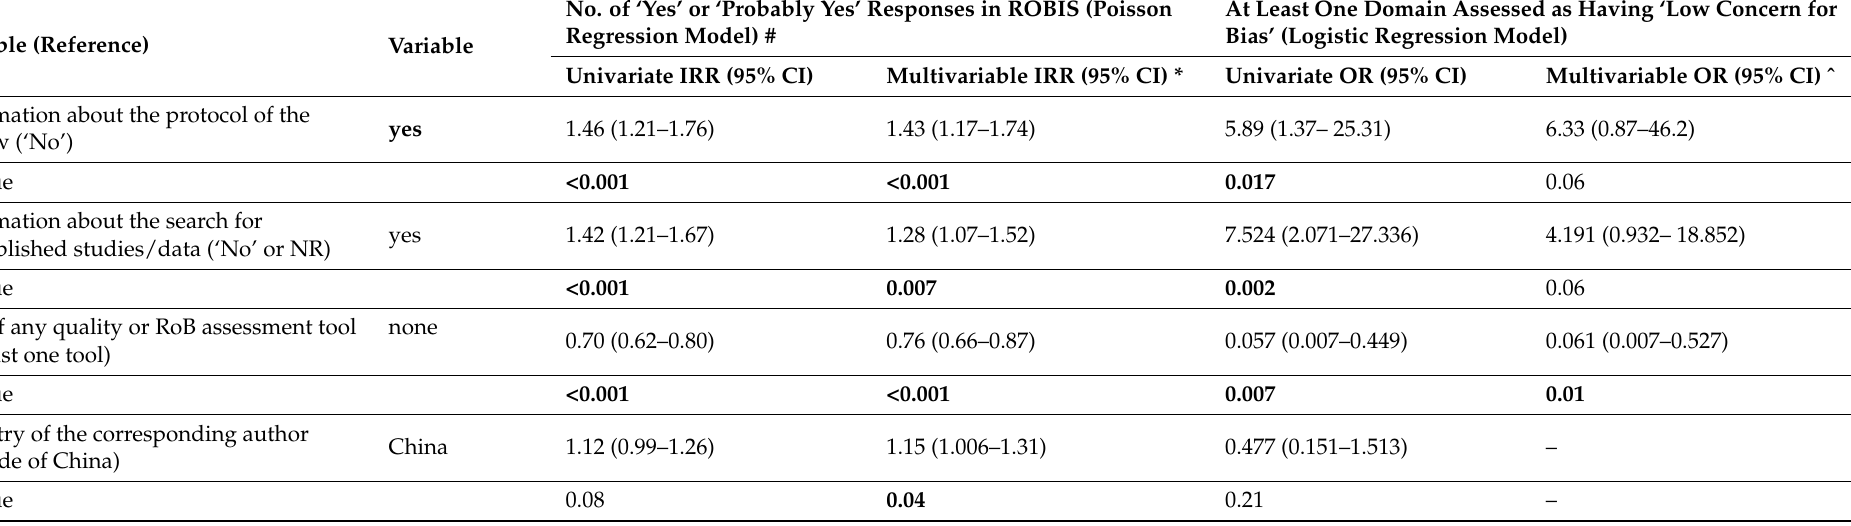
Table 2. Predictors of the number of ‘Yes’ or ‘Probably Yes’ responses in ROBIS (Poisson or logistic regression model) and at least one of the ROBIS domains assessed as having low concern for bias (logistic